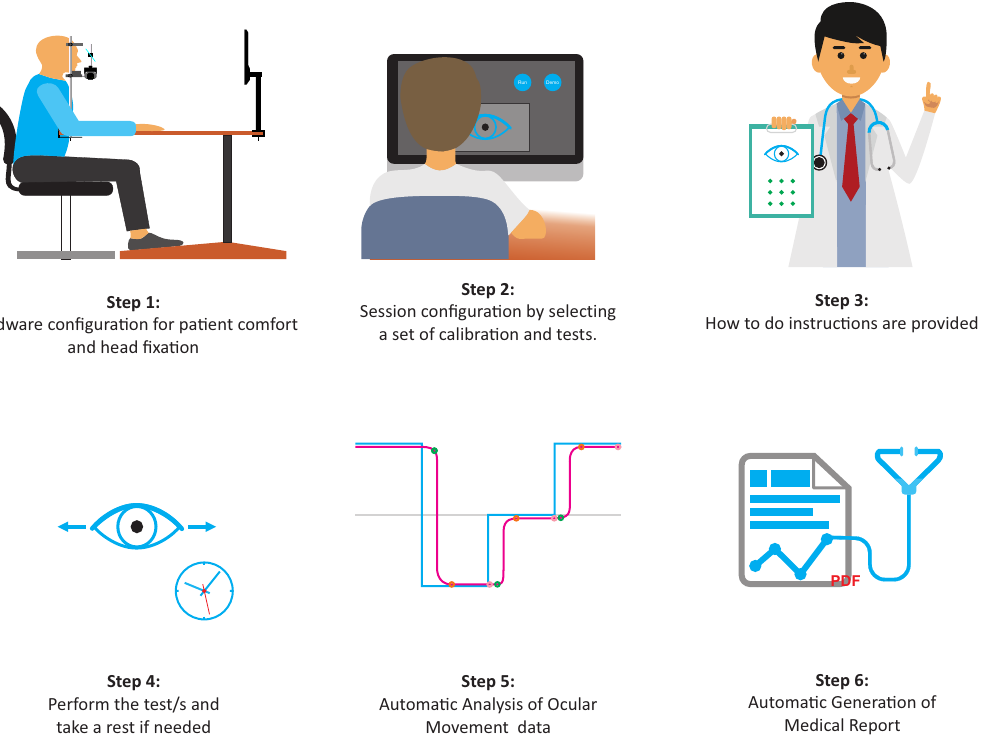
Figure 1. Overview of the steps required for optimum use of